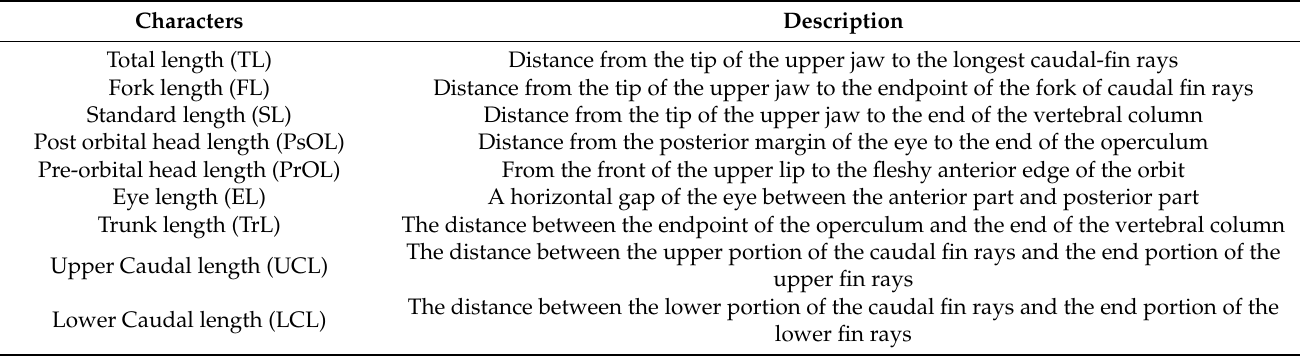
Table 2. Nine morphometric characters were used for the analysis of peppered loach, Botia dario stock variations.